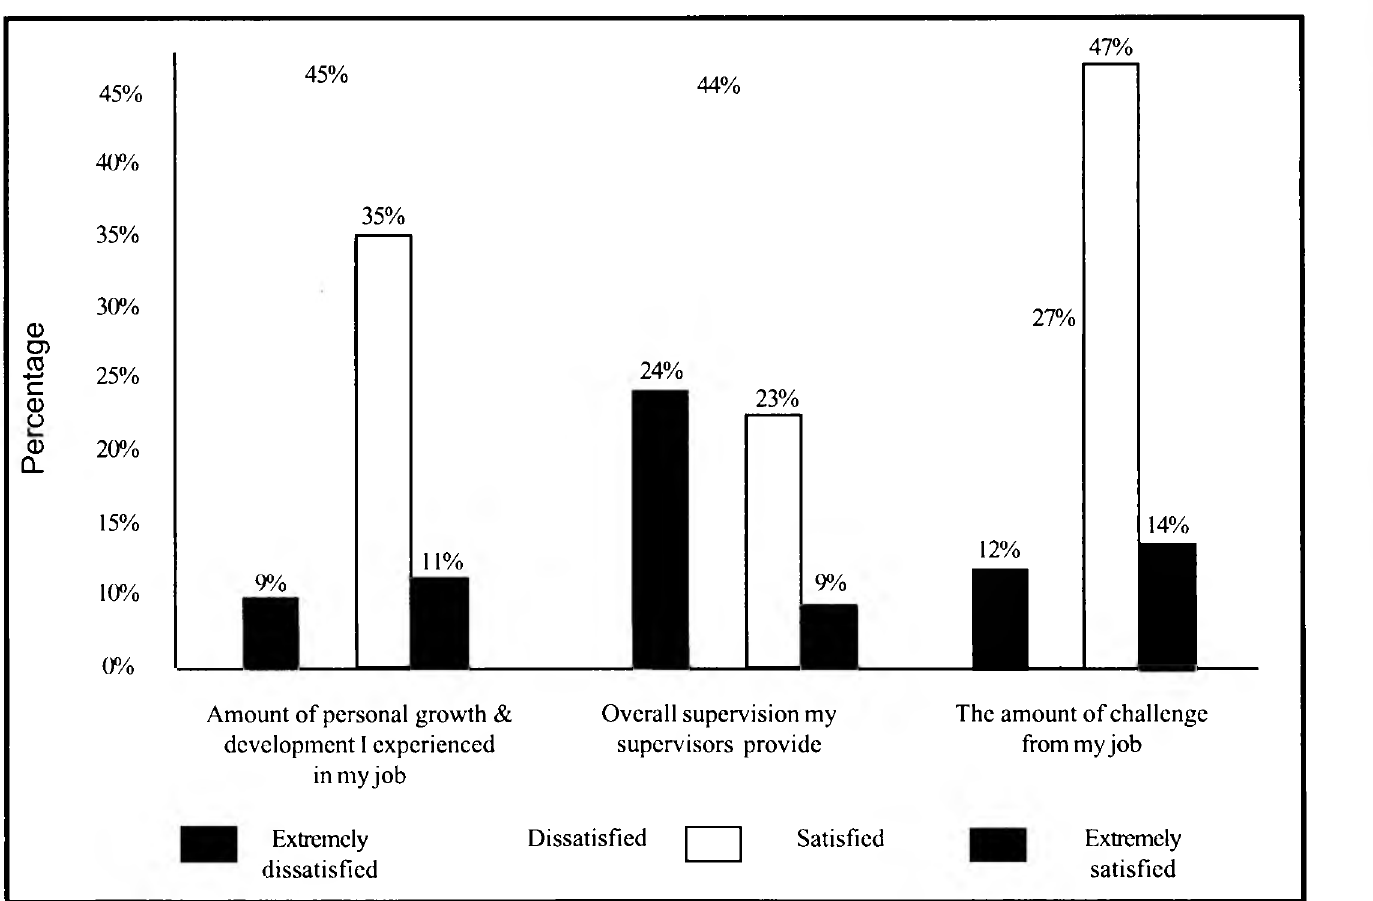
Figure 3: Factors relating to personal aspects